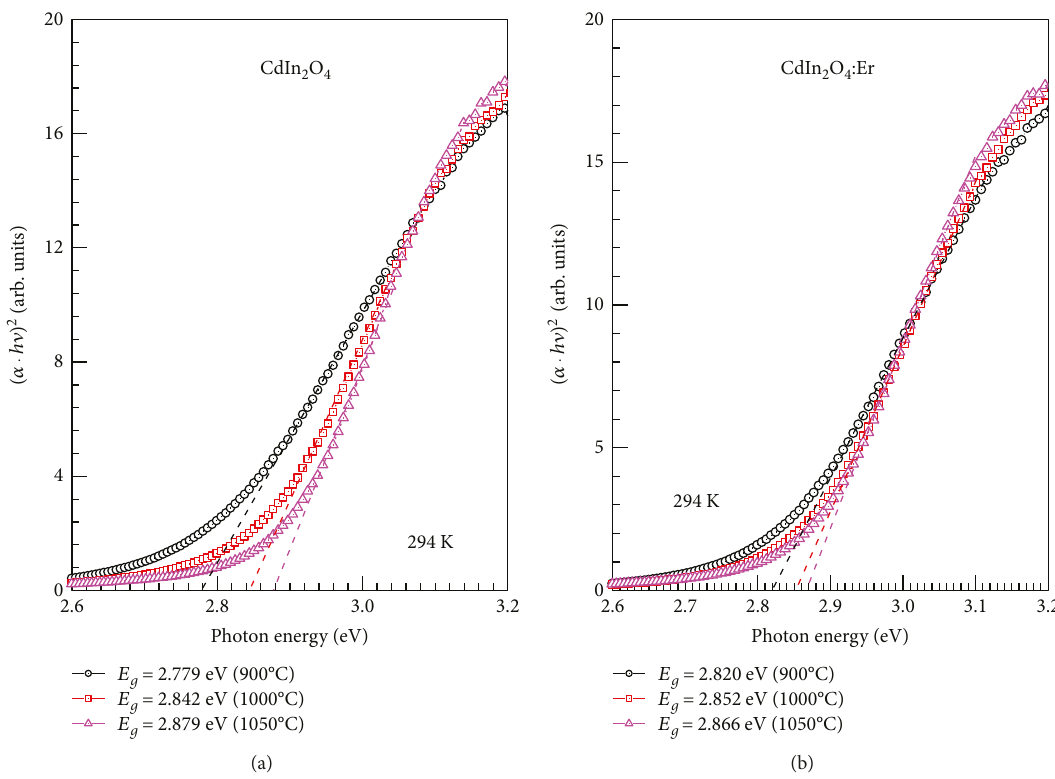
Figure 2: Plot of α ⋅ hv 2 versus the incident photon energy hv in CdIn